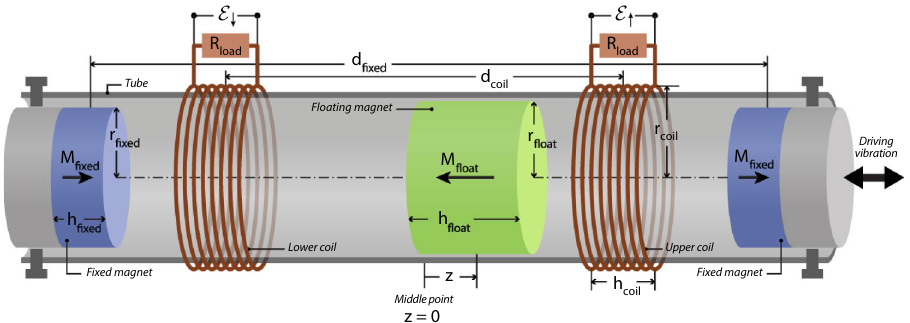
Figure 1. Schematic drawing of the considered EMVEH device. The two blue magnets in each end of the tube are fixed and have their magnetisation, M fixed , pointing in the same direction. The green magnet in the middle is free to move and has its magnetisation, M float , pointing in the opposite direction. Each of the two coils coloured in red is coupled to an external resistive load. The radius, r , and the height, h , of the different components are also